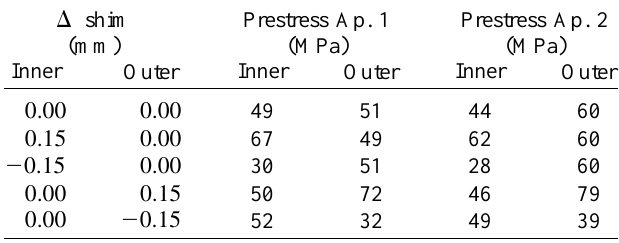
TABLE I. Shim thickness variation (mm) and corresponding prestress (MPa) for the inner and the outer layers, experi- mental